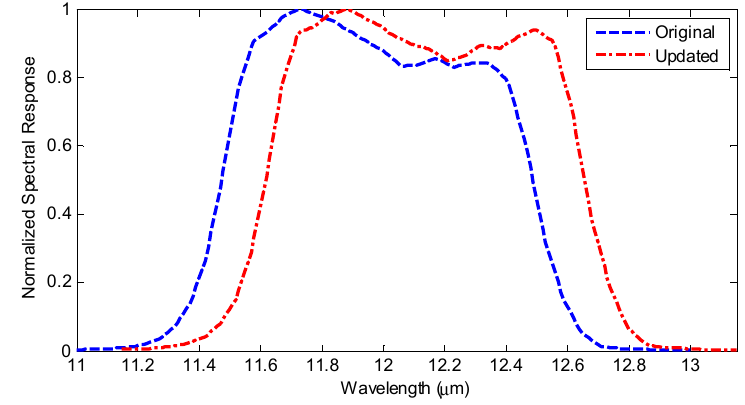
Figure 8. The original and updated SRFs of the FY-2G IR2 (12.0 μ m) band.